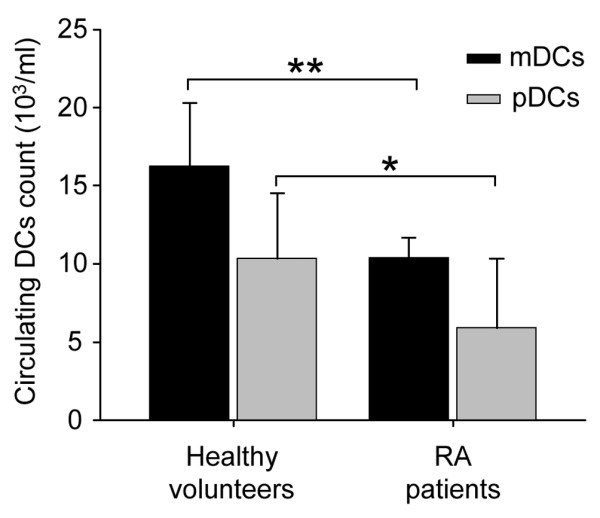
Circulating dendritic cell subset levels in patients with active rheumatoid arthritis and in healthy volunteers. Dendritic cell (DC) subsets were measured in the peripheral blood of patients with rheumatoid arthritis (RA) (n = 61) and in healthy subjects (n = 30). The mean numbers per milliliter of blood of CD11c+CD123-Lin-HLA-DR+ myeloid dendritic cells (mDCs) and CD11c-CD123+Lin-HLA-DR+ plasmacytoid dendritic cells (pDCs) are shown (mean ± standard deviation). *P < 0.0001 and **P < 0.001, Mann–Whitney U test.